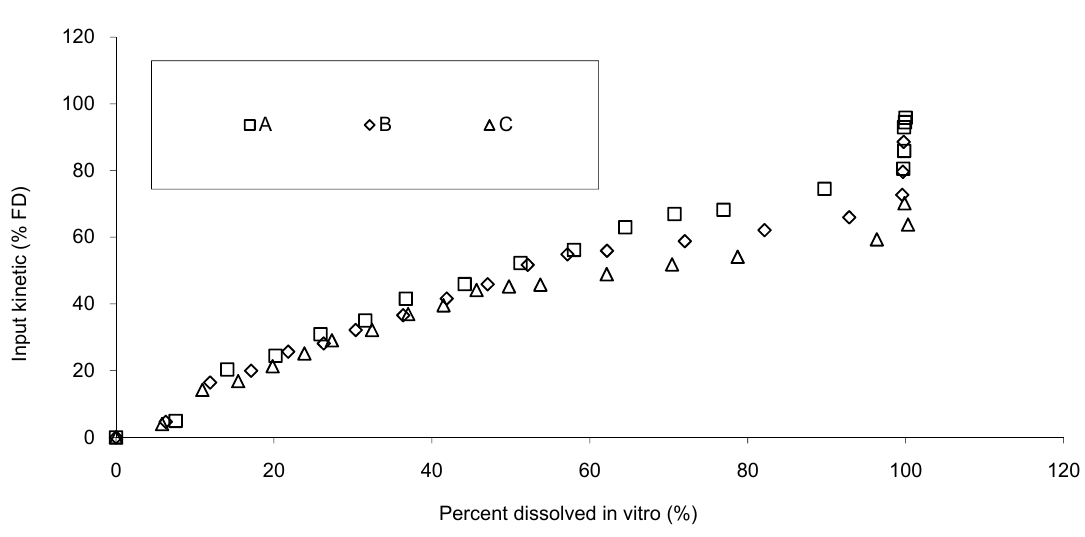
Figure 5. Dissolution vs . input kinetics of Hydrocodone after administration of tablet A , B and C , first attempt of IVIVC.